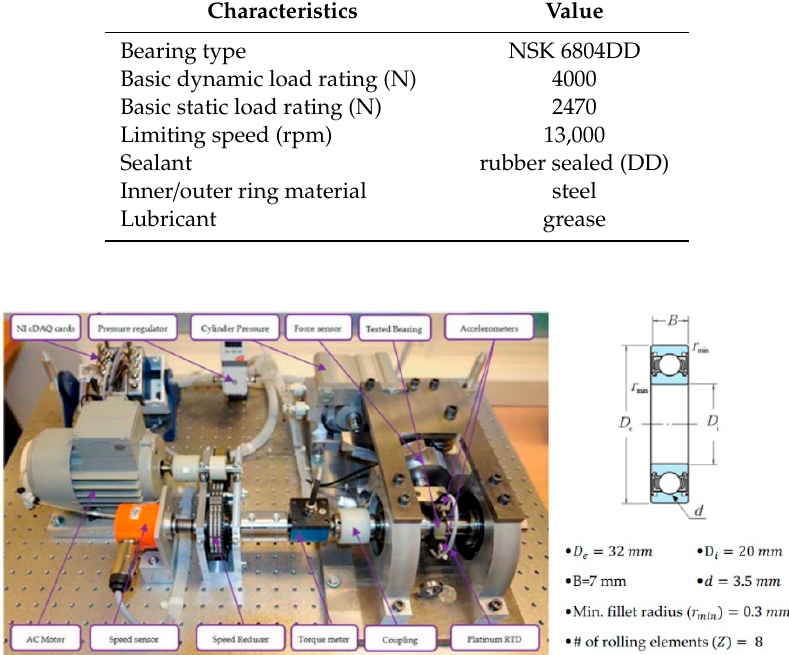
Figure 2. Detailed labeling of the experimental platform and the ball bearing dimensions. Table 1. Technical data of the ball bearings.